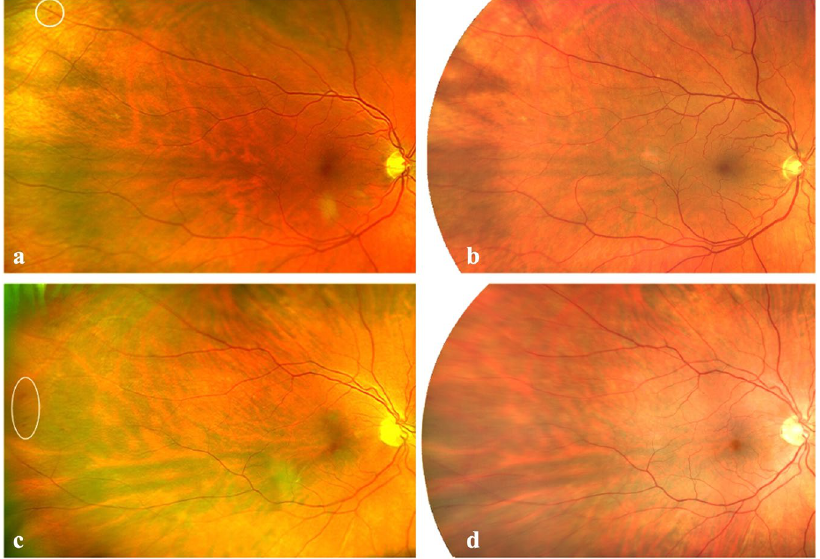
Figure 3. Optos images of two right eyes ( a , c ) of two patients with peripheral temporal lesions highlighted with white circles outside the field of view of the corresponding Clarus images shown in ( b ) and ( d